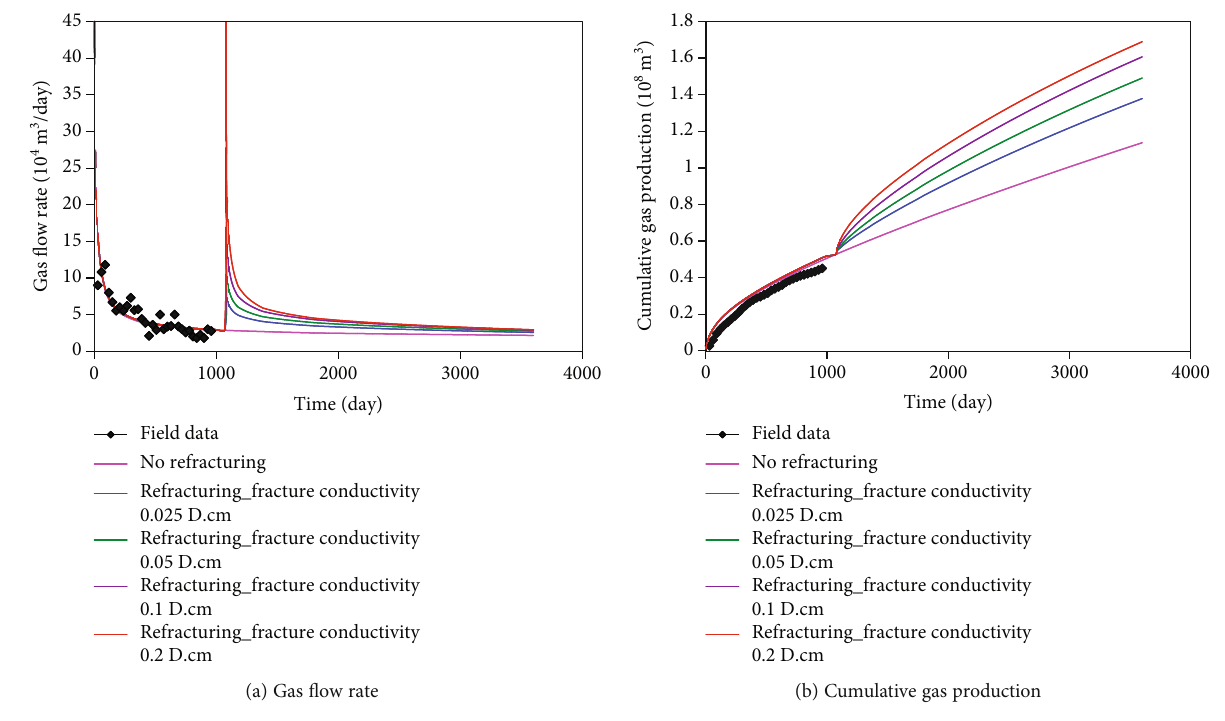
Figure 16: E ff ect of conductivity of refractured new fracture on gas fl ow rate and cumulative production. Table 6: Production increase percentage after 7 years based on di ff erent fracture conductivities. Fracture conductivity (D ·